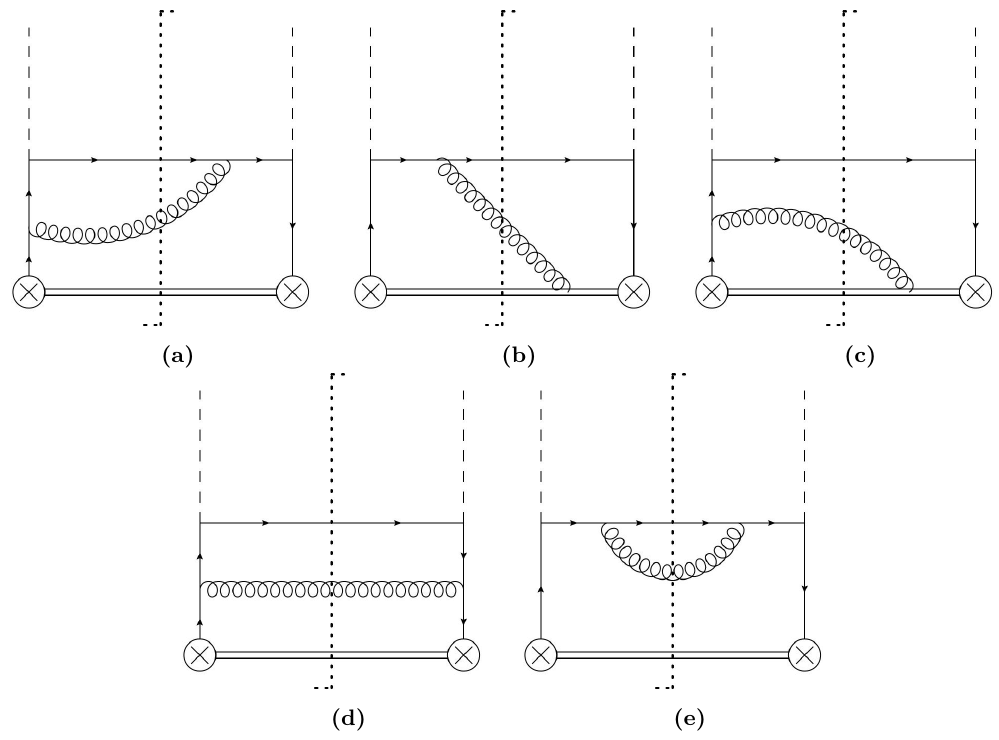
Figure 3. The diagrams for the real corrections to D t → H . There are also conjugate diagrams to (a), (b) and